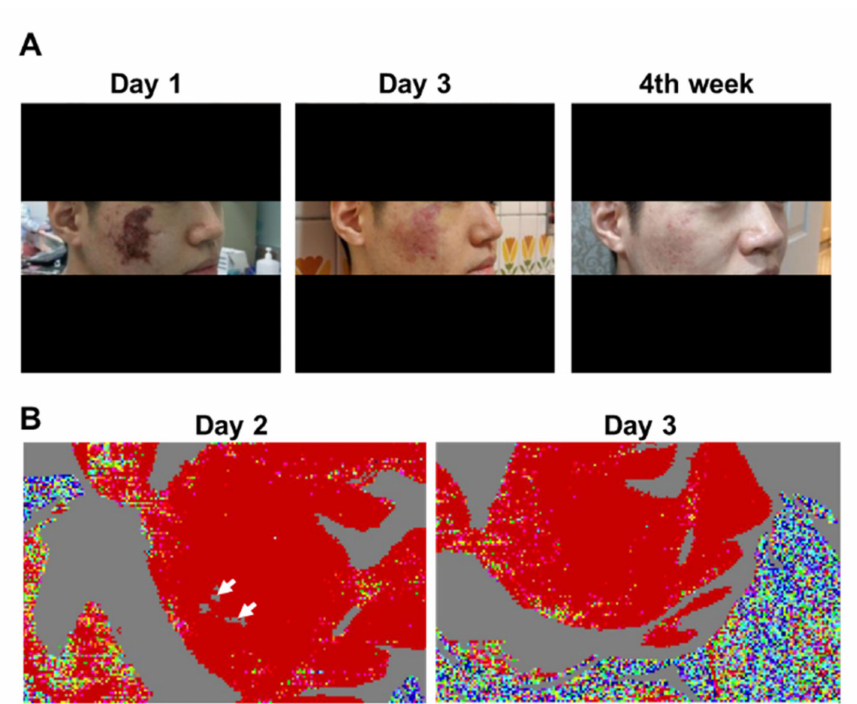
Figure 3. Clinical photographs and laser Doppler imaging of Patient 6. ( A ) Day 1 of admission; Day 3 of admission; Week 4 of follow-up. Gradual improvement in cutaneous symptoms can be observed. ( B ) Left panel: on Day 2 of admission, areas of cutaneous ischemia were clearly delineated from those without vascular occlusion. Right panel: on Day 3 of admission, facial blood circulation was